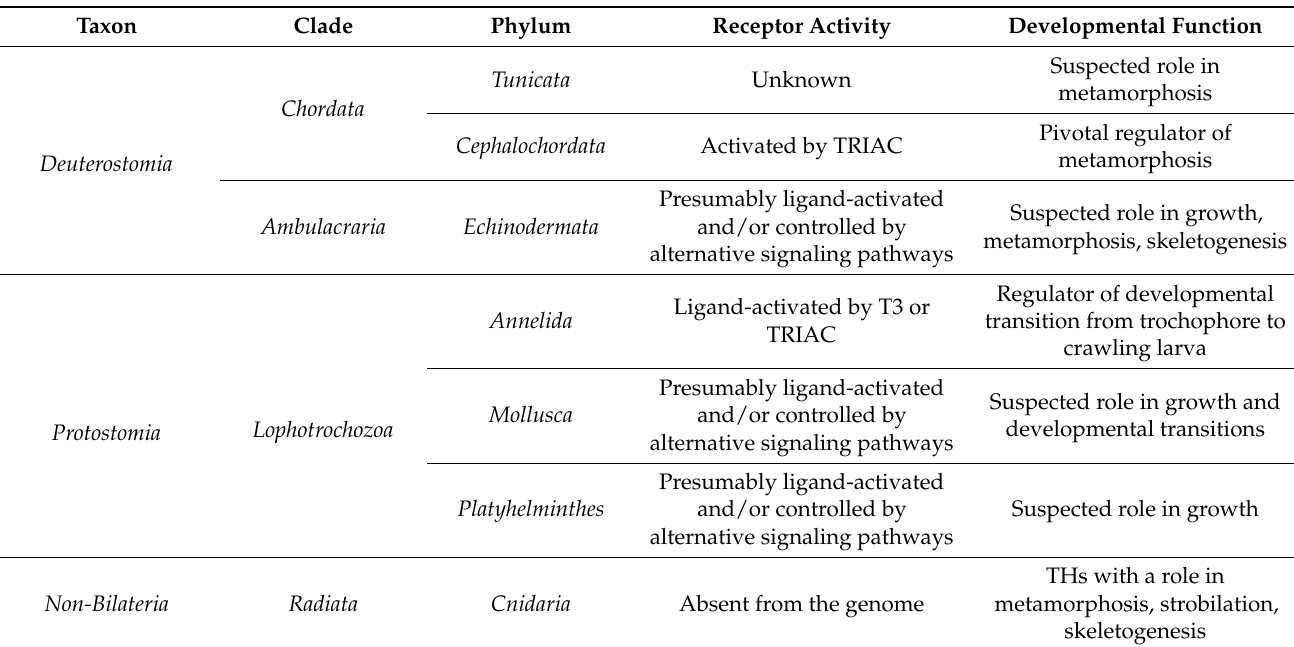
Table 2. Summary of thyroid hormone receptor (THR) functions in marine